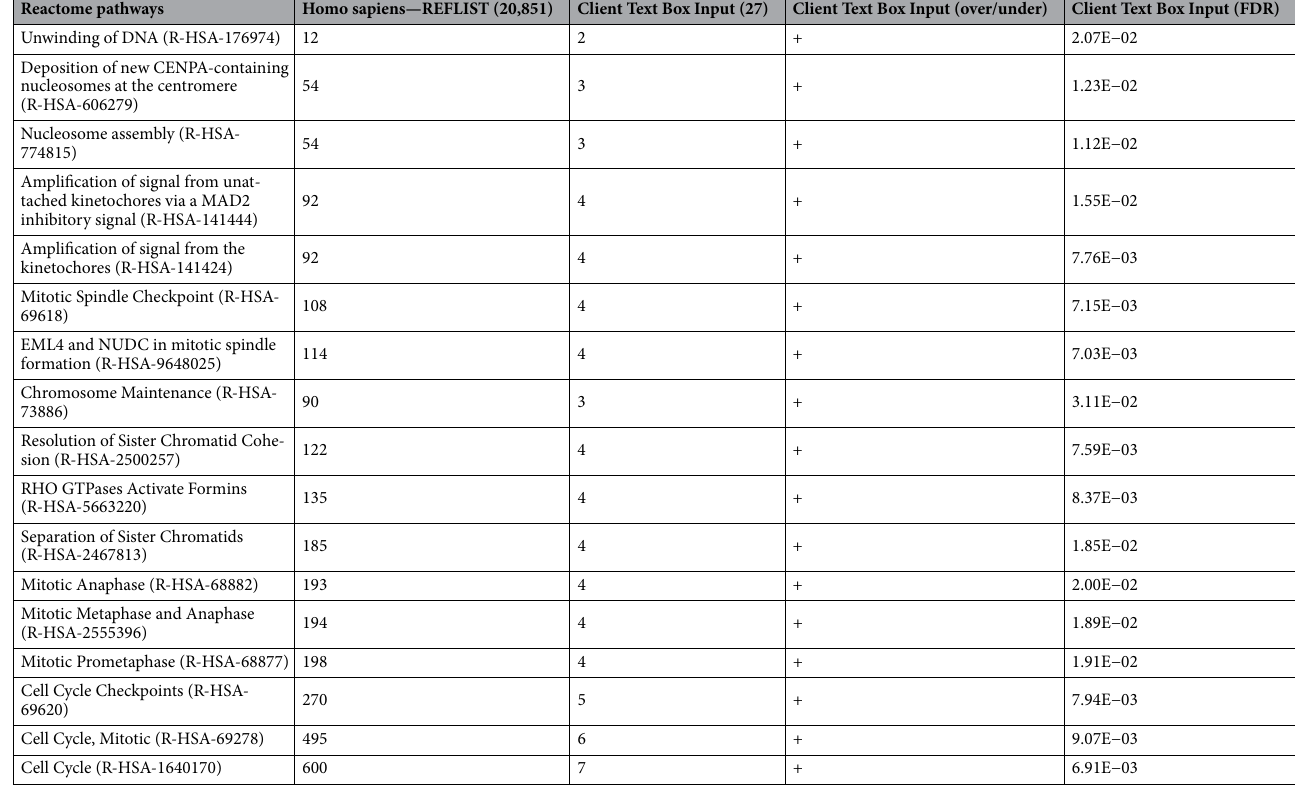
Table 2. Gatekeepers: Enrichment test-Reactome pathways. Main reactome pathways are shown if False discovery rate value was less than 0.05.